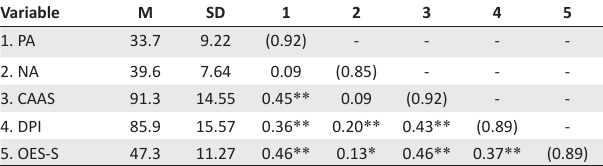
TABLE 1: Means, standard deviations and correlations of study variables.